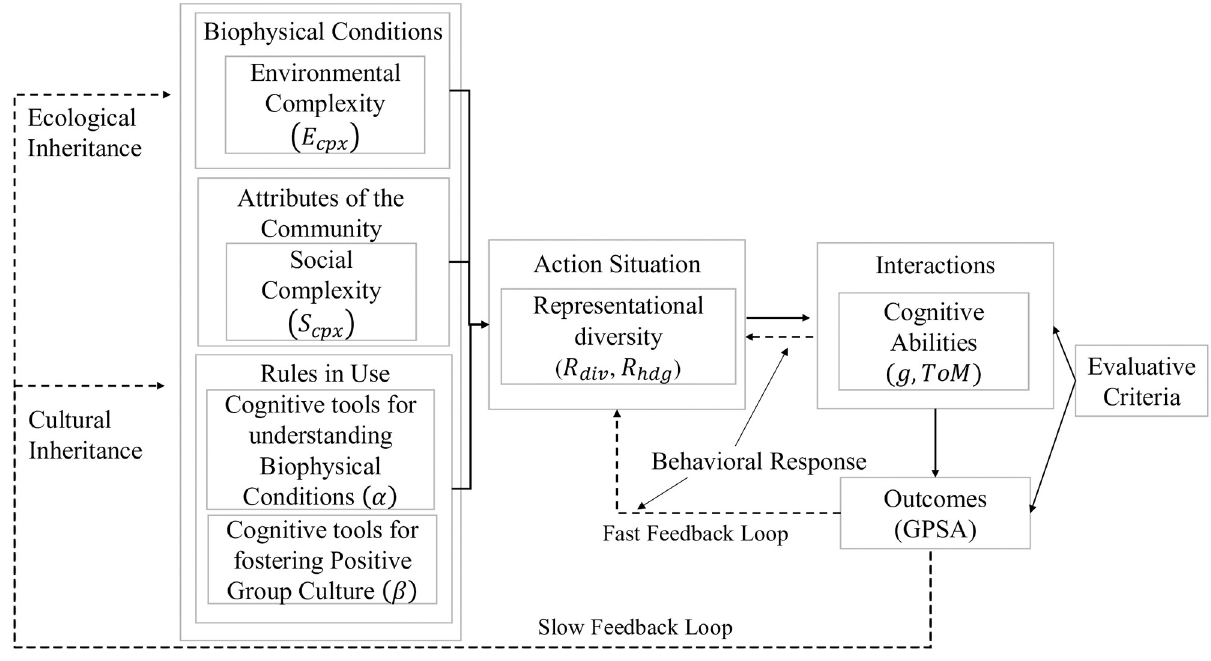
Fig 1. The IAD framework (adapted from [17]) depicts how slow variables (i.e. biophysical conditions, attributes of the community, and rules in use) generate action situations, which, in turn, generate interactions among agents for collective decision making and problem solving. In the adapted framework, we specify environmental complexity E as being a key attribute of biophysical conditions, social complexity S as a key attribute cpx cpx of the community, and cognitive tools as a factor affecting rules in use. Cognitive tools refer to the mean traits of a group inherited as a consequence of past technological adaptations and social interactions. We define two sets of tools: (1) traits that can foster a better understanding of the biophysical environment and its dynamics ( α ), and (2)traits that foster a positive group culture ( β ). Complexity and cognitive tools result from cultural inheritance and constitute parameters that impact interactions between and within groups in specific action situations. Interactions in action situations depend on specific cognitive abilities (here the ability to correctly represent key dynamics within the environment ( g ), and the ability to model others intentions ( ToM ). Interactions, together with complexity and cognitive tools affect the representational diversity ( R div ) as well as the ability of groups to harness ) in an action situation, and give rise to specific outcomes that are partly ascribed to a group’s problem solving ability ( GPSA ). such diversity ( R hdg Outcomes are then evaluated via specific criteria and potentially modified via learning and collaboration in the behavioral (fast) feedback